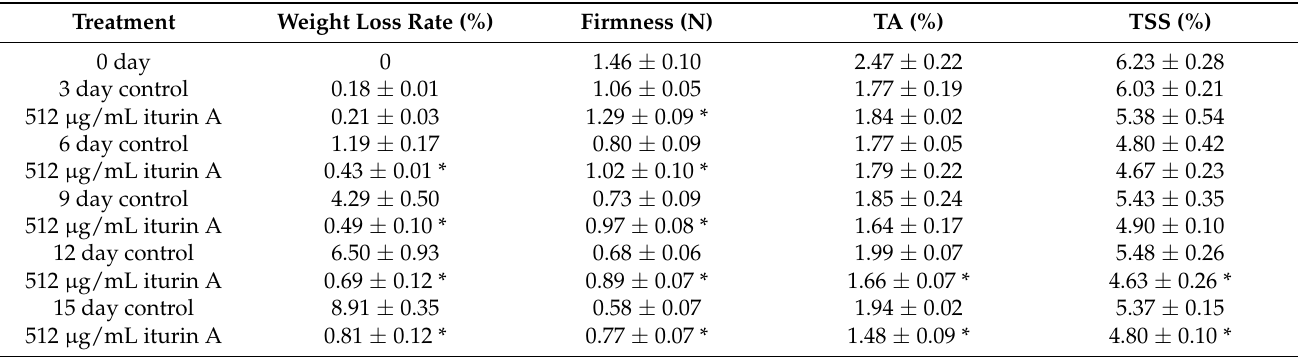
Table 1. Effects of iturin A on quality index including weight loss rate, firmness, total acidity (TA), and total soluble solid (TSS) of cherry tomato fruit during 15 days of storage at 30 ◦ C. The asterisks represent significant differences between the iturin A treatment and the control by the unpaired t -test ( p < 0.05).